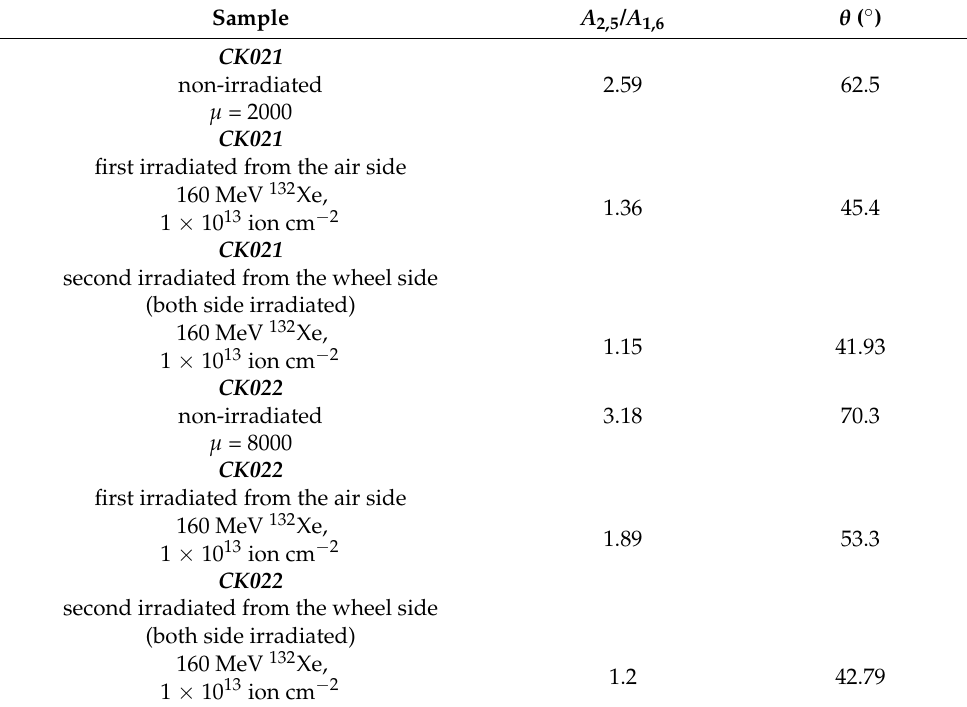
Table 1. Effect of swift heavy ion irradiation on the orientation of magnetization in the bulk of differently stress-annealed FINEMET